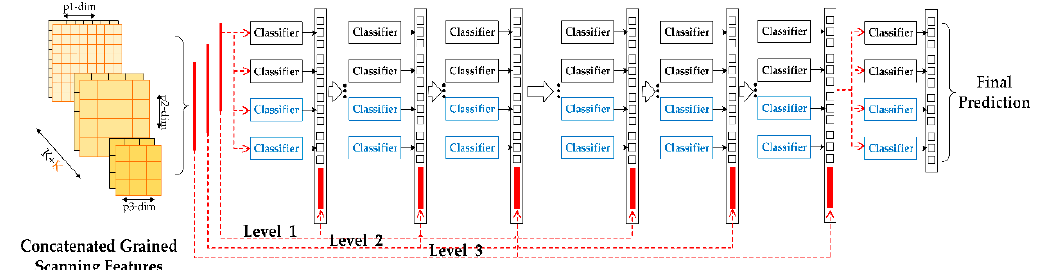
Figure 4. Process of the cascade.